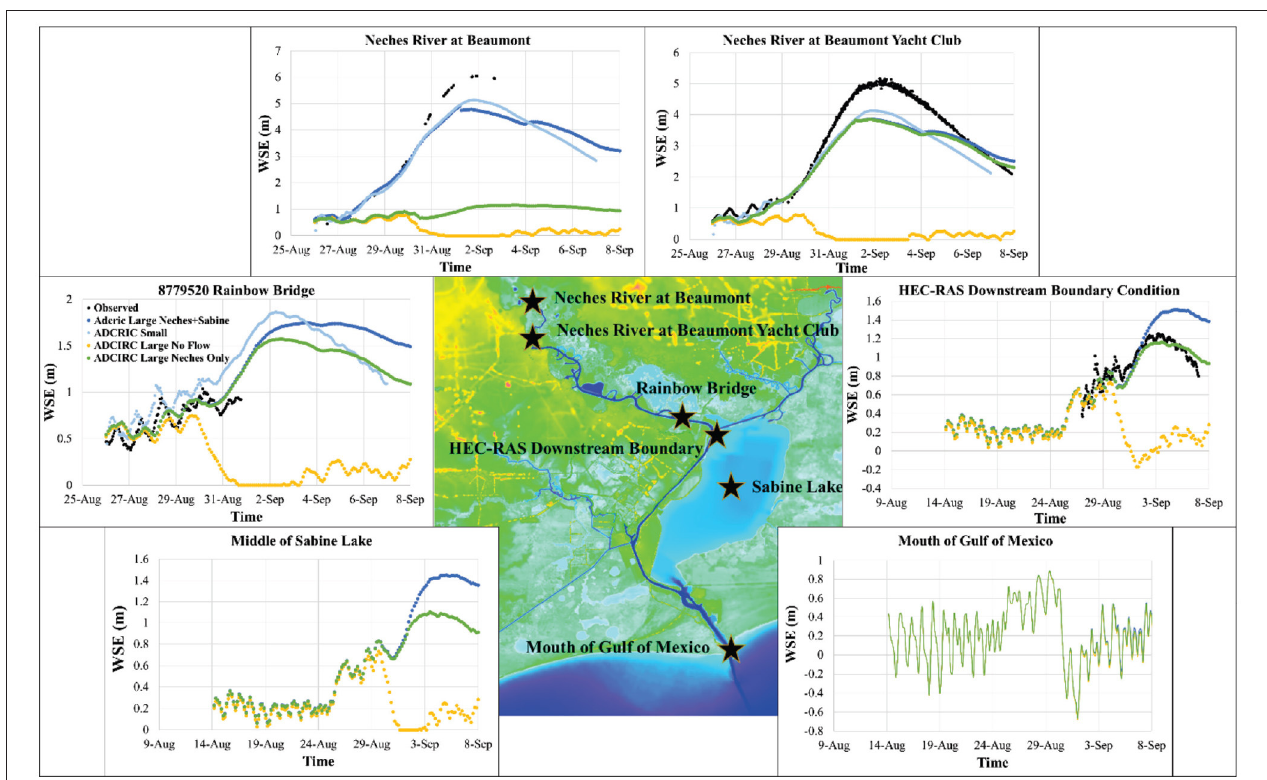
FIGURE 6 | ADCIRC output for different scenarios at the location of all comparison stations shown in the center colored